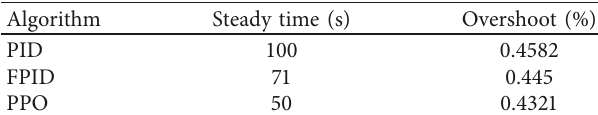
Figure 16: Simulation curves of feedwater flow and feedwater temperature. Table 5: Performance indicators of the three algorithms when the feedwater temperature step rises to 80 ° C.